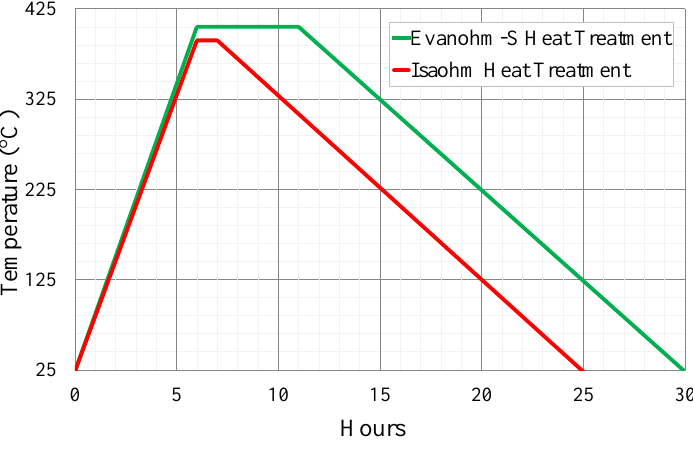
Figure 7. Heat treatment process to achieve TCs under 1 µ Ω / Ω / ◦